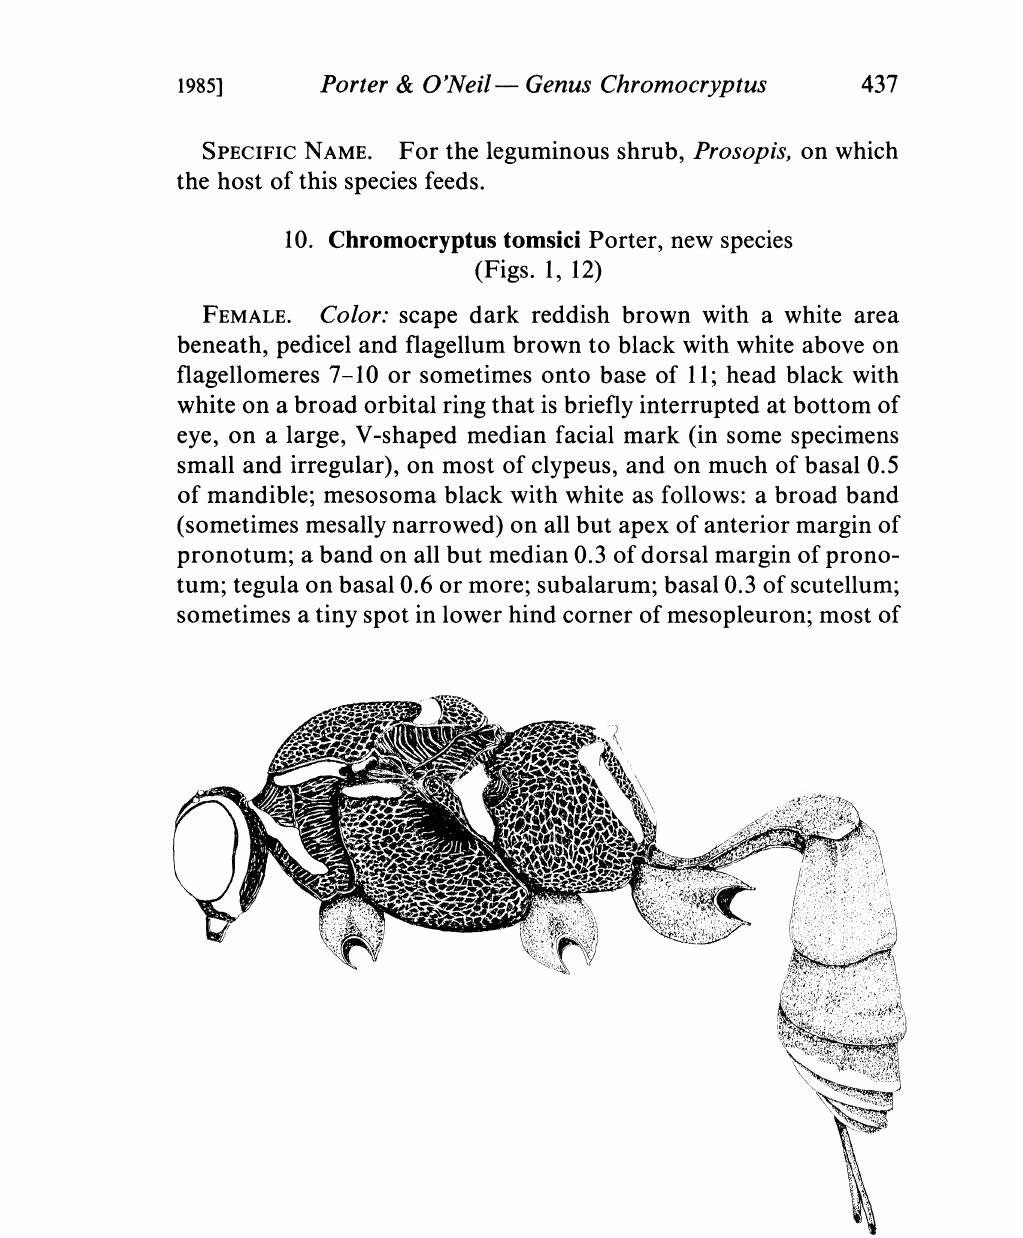
Fig. 12. Chromocryptus tomsici, habitus and color